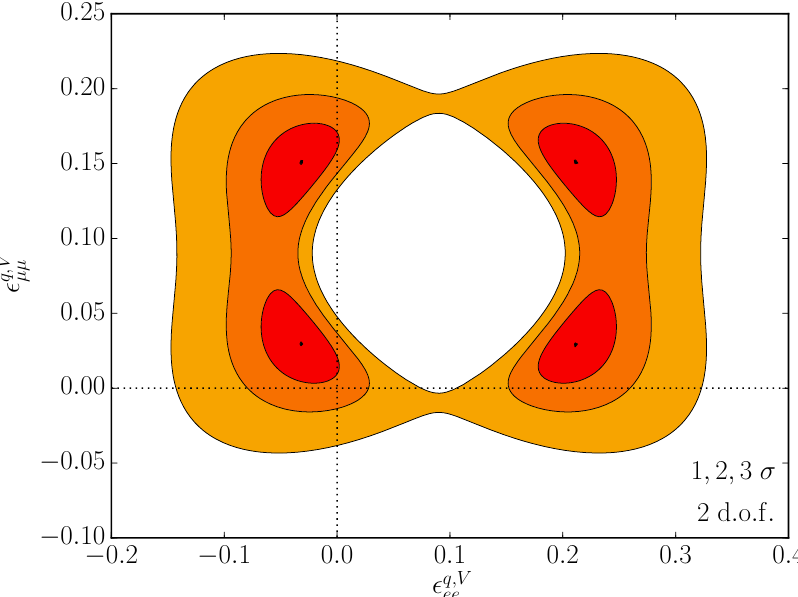
Figure 3 . The 1, 2, and 3 (cid:27) constraints (2 d.o.f.) for the two diagonal NSI terms from COHER- ENT’s measurement using timing information where all other NSI terms are set to zero. We have assumed that (cid:15) u = (cid:15) d as required by underlying models for NSI and have taken the mediator to be heavy. At the best (cid:12)t points the (cid:31) 2 = 0.